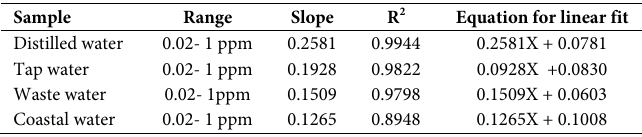
Table 2. Calibration curve in different matrix